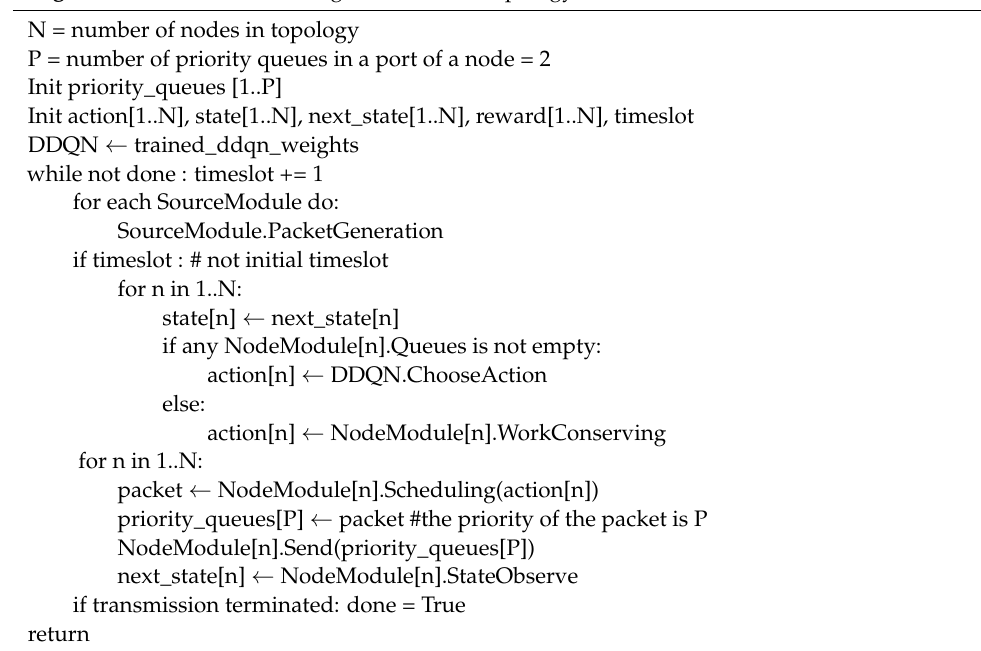
Algorithm 1 DDQN scheduling simulation in